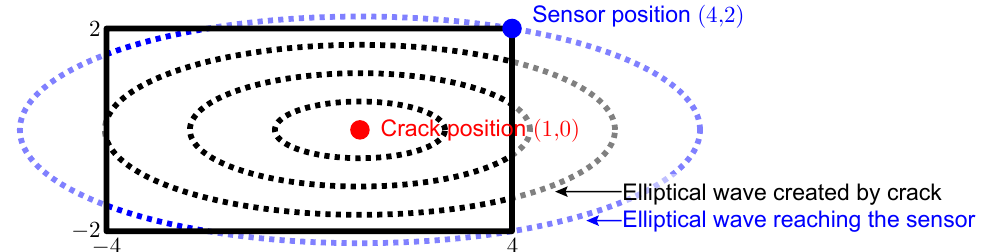
Figure 3. Illustrative figure showing the numerical experiment settings. The signal arrival time measured through the numerical experiment was obtained from the ellipse, where the elliptical wave initiated by the crack at the red dot reached the sensor position, which is the blue